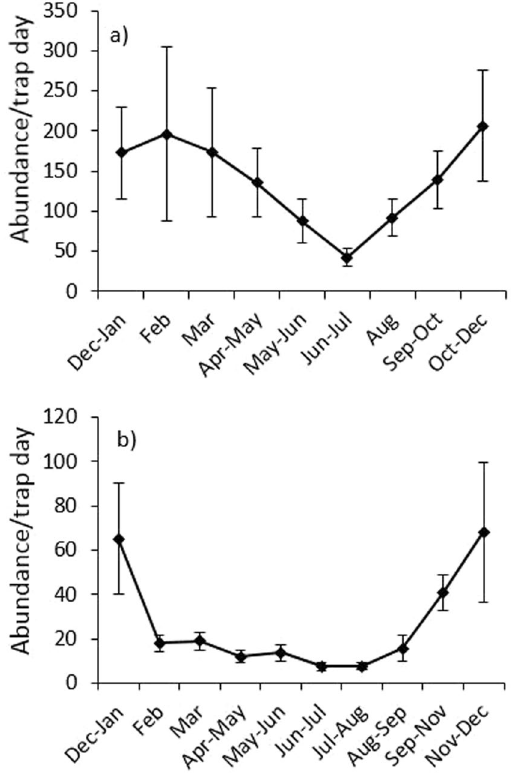
Figure 2. Seasonal variation in the mean ( ± SE) abundance/trap day of all beetles across all elevations on ( a ) the Atherton transect, and ( b ) the Paluma transect. Note that the temporal axes are not to scale.